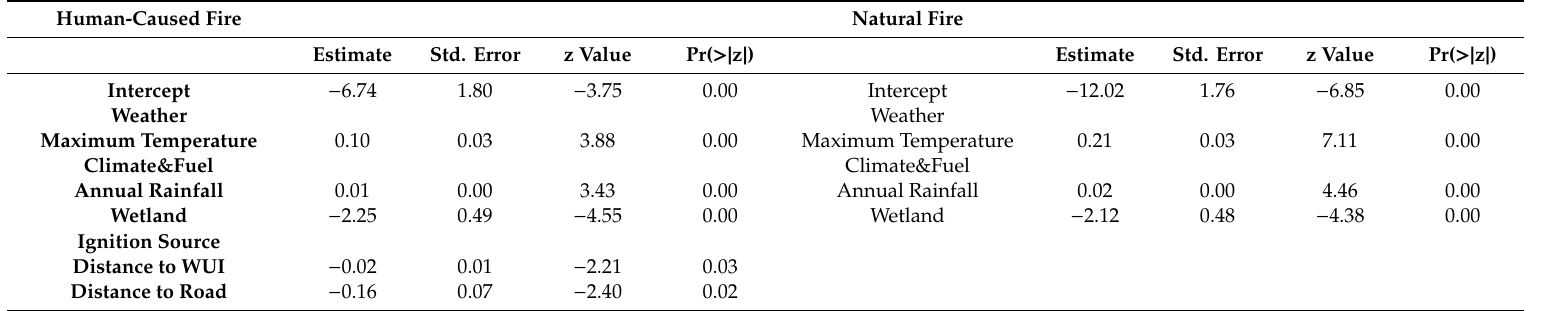
Table 5. Estimates from the best-performing models for human-caused and natural